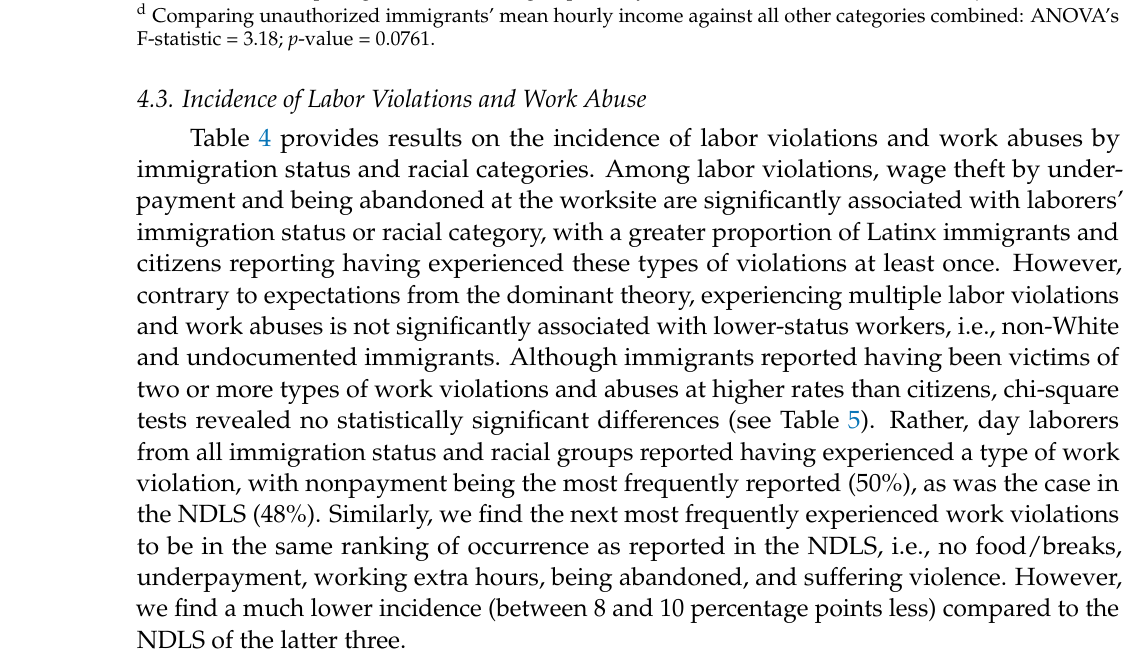
Table 4. Incidence of work violations and abuses a,b